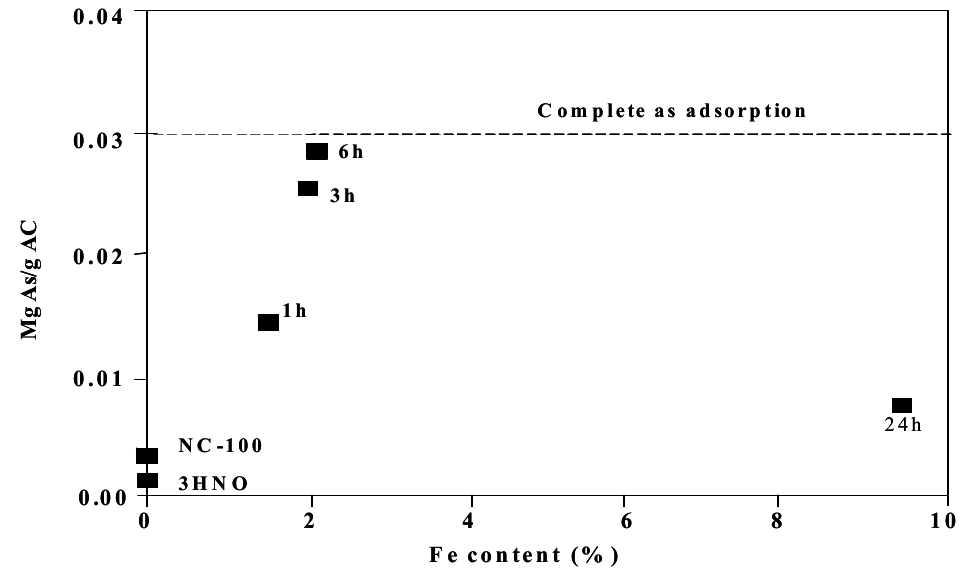
Figure 6. Arsenic uptake of all the investigated materials (raw and iron-doped ACS), as a function of their Fe content [after 84].